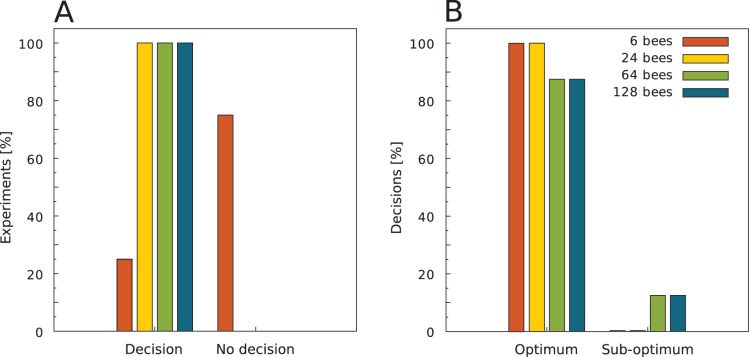
Collective decision in the four different group sizes.(A) The percentage of experiments with statistically significant collective decisions and (B) the percentage of the decisions for either the optimum or the sub-optimum is shown for all four group sizes. Note that (B) only includes data for when a collective decision was made by the bees.